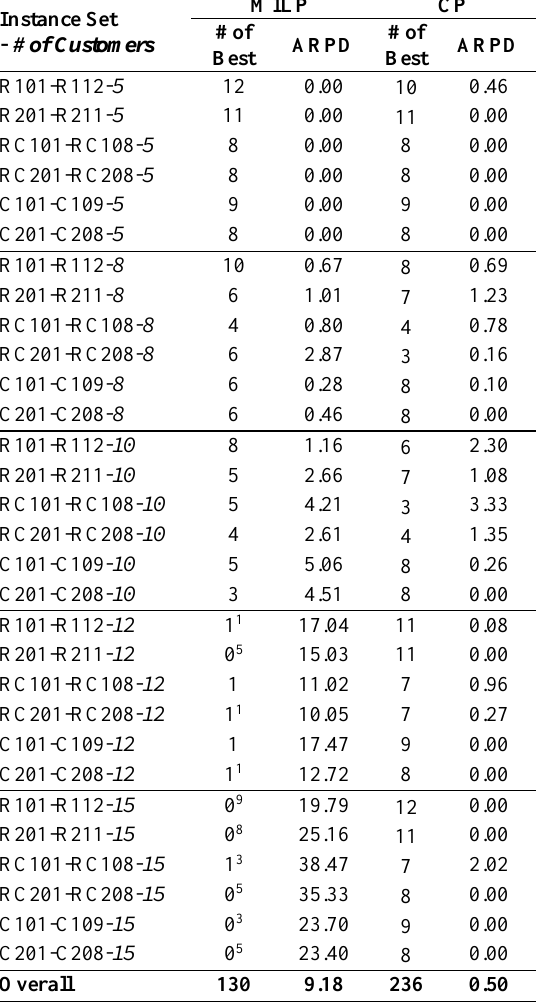
Table 2. The results for the MILP and CP models under 60 minutes time limit.